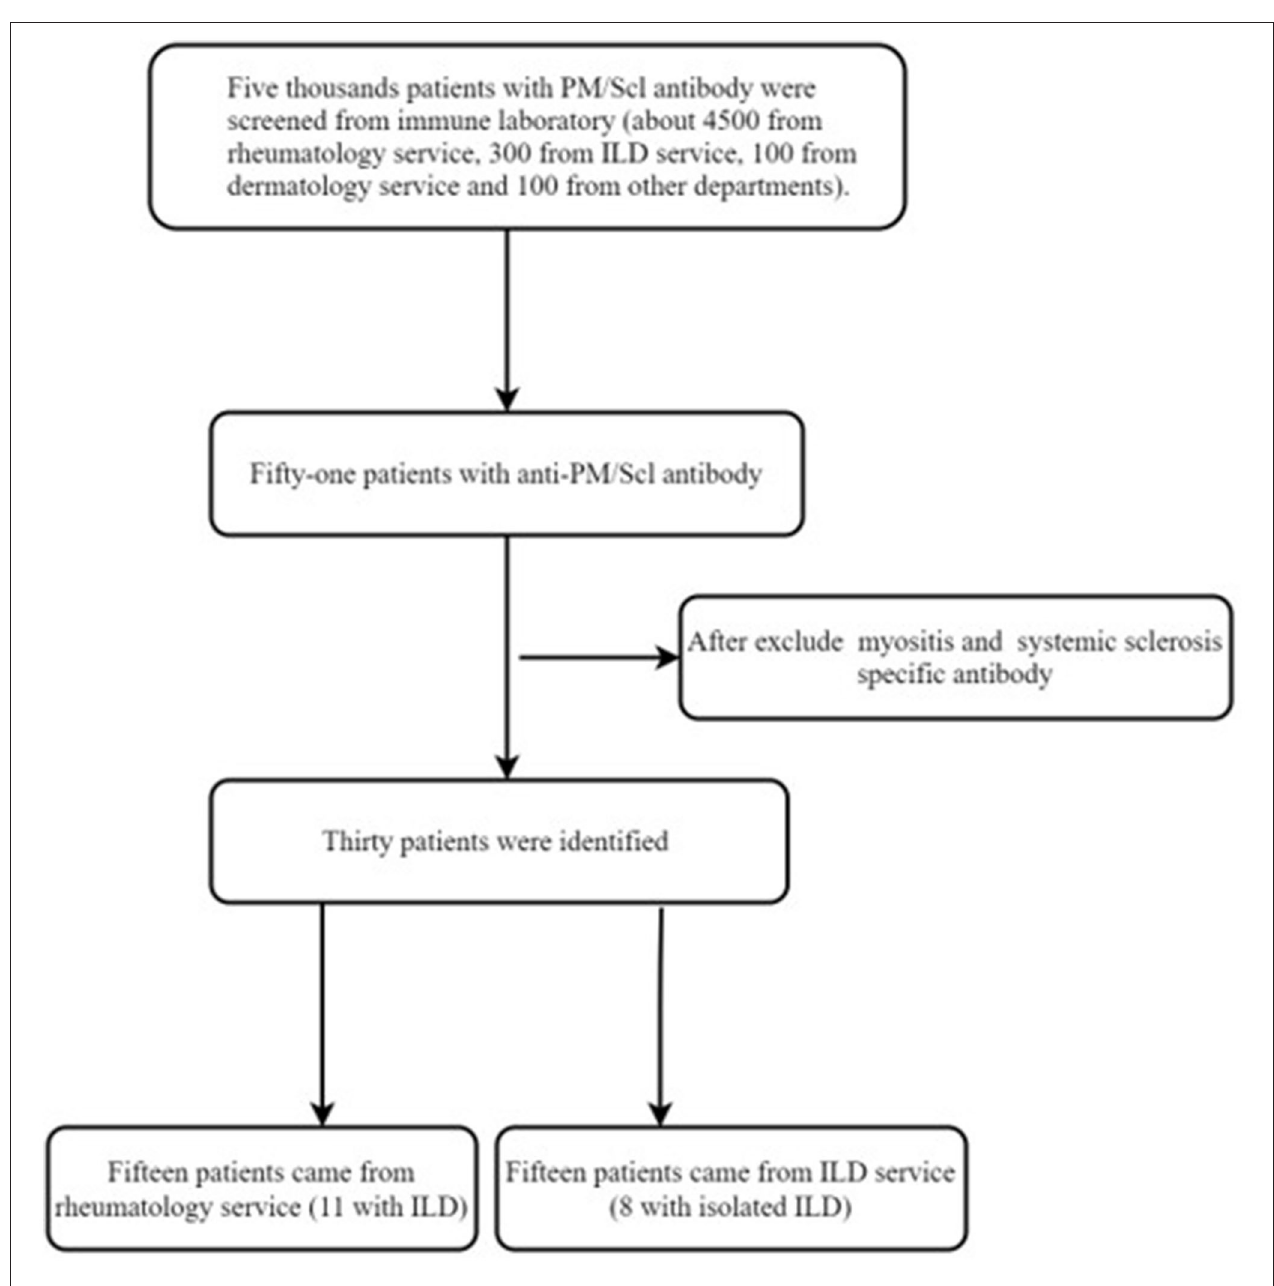
FIGURE 1 | Selection